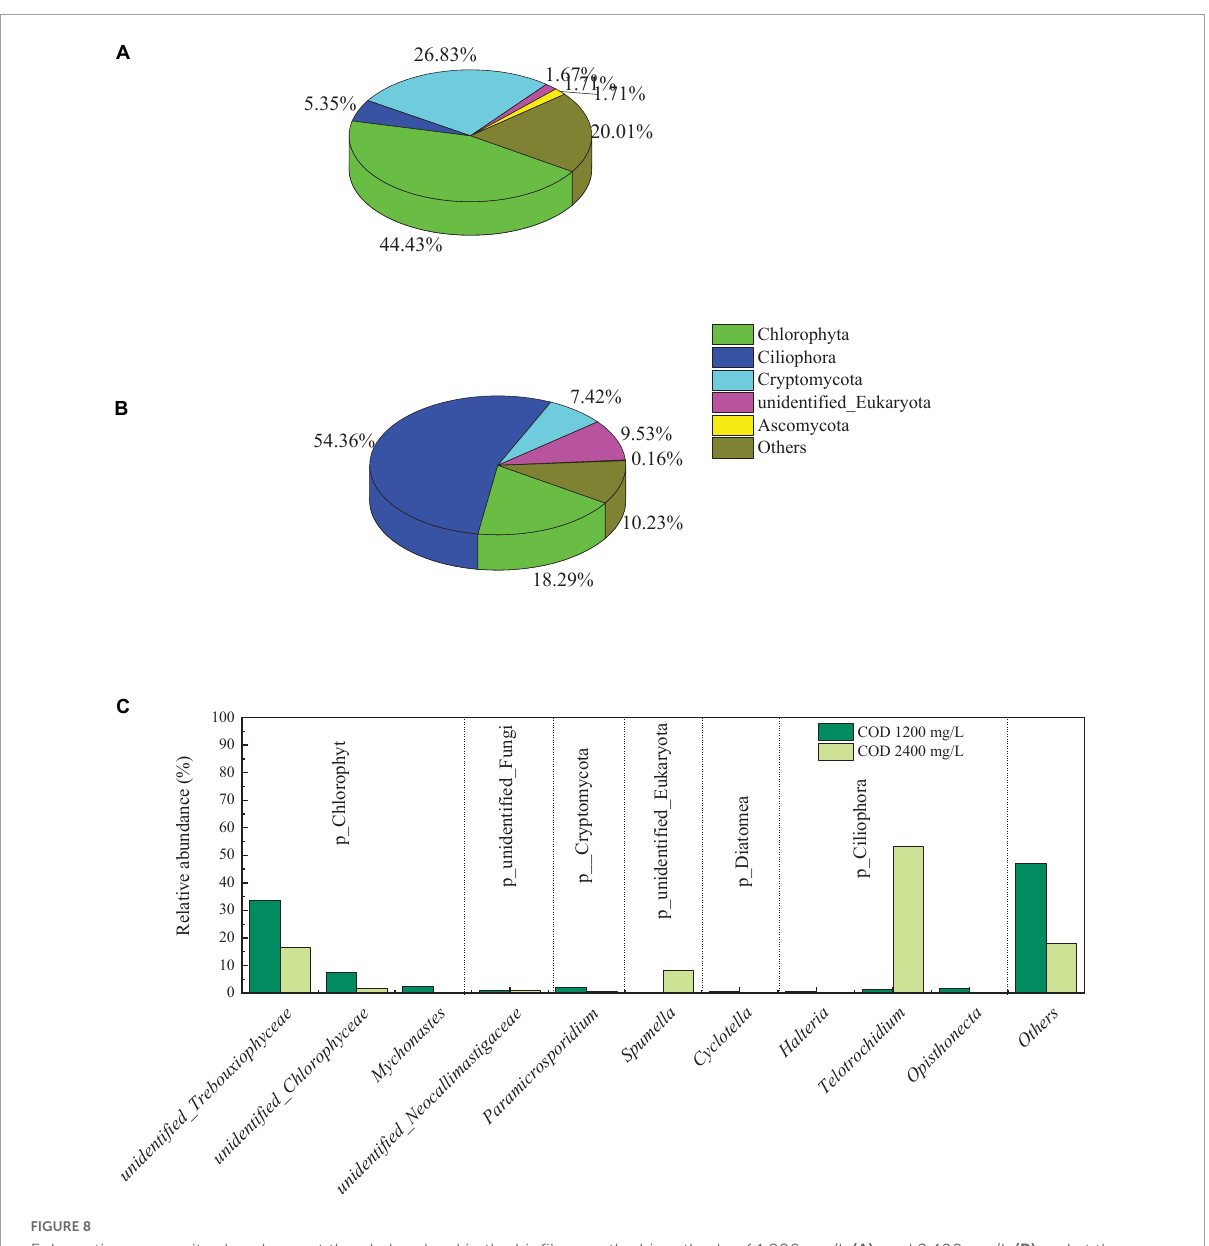
FIGURE8 Eukaryotic community abundance at the phylum level in the biofilms on the biocathode of 1,200 mg/L (A) , and 2,400 mg/L (B) and at the genus level (C) .